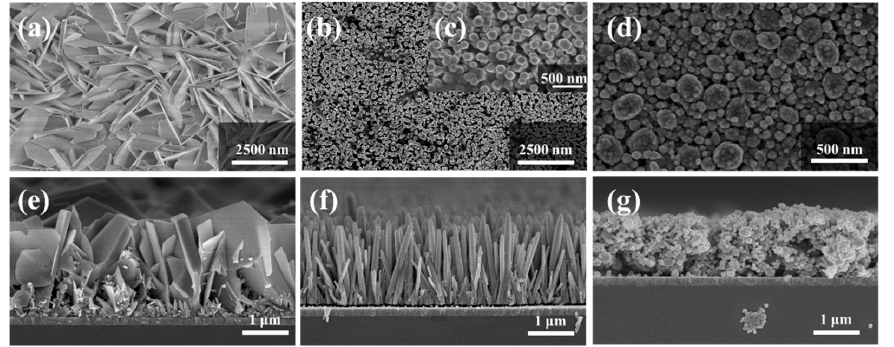
Figure 2. The morphologies of three ZnO nanostructures. SEM image of ( a ) ZnO NSs, ( b , c ) ZnO NRs, and ( d ) ZnO NPs. Cross-sectional SEM image of ( e ) ZnO NSs, ( f ) ZnO NRs, and ( g ) ZnO NPs. Moreover, the crystalline structures of the three samples were confirmed by XRD analysis. Figure 3a shows the XRD spectrums of the various ZnO nanostructures that were grown on the FTO substrate, and Figure 3b presents vertically enlarged XRD patterns of the inside of the pink dashed line in Figure 3a. The ZnO NRs peaks are detected at 34.43°, 36.25°, 47.52°, and 62.86°, and they represent lattice planes (002), (101), (102), and (103), respectively. The ZnO NSs peaks are detected at 31.70°, 34.42°, 36.25° and 56.46°, and they represent lattice plane (100), (002), (101) and (110), respectively. Similarly, The ZnO NPs peaks are detected at 31.70°, 34.42°, 36.25°, and 56.46°, and they represent lattice plane (100), (002), (101), and (110), respectively. The detected peaks of three ZnO nanostructures match the standard ZnO diffraction pattern (JCPDS, No. 36-1451), indicating that three morphologies of ZnO have the same crystalline structure, which is a wurtzite structure. Notably, the peak at 34.43° is the highest in the ZnO NRs, indicating that the ZnO NRs are mainly grown on a lattice plane (002). The results of the XRD of three ZnO nanostructures match well with the results of their SEM images. 20